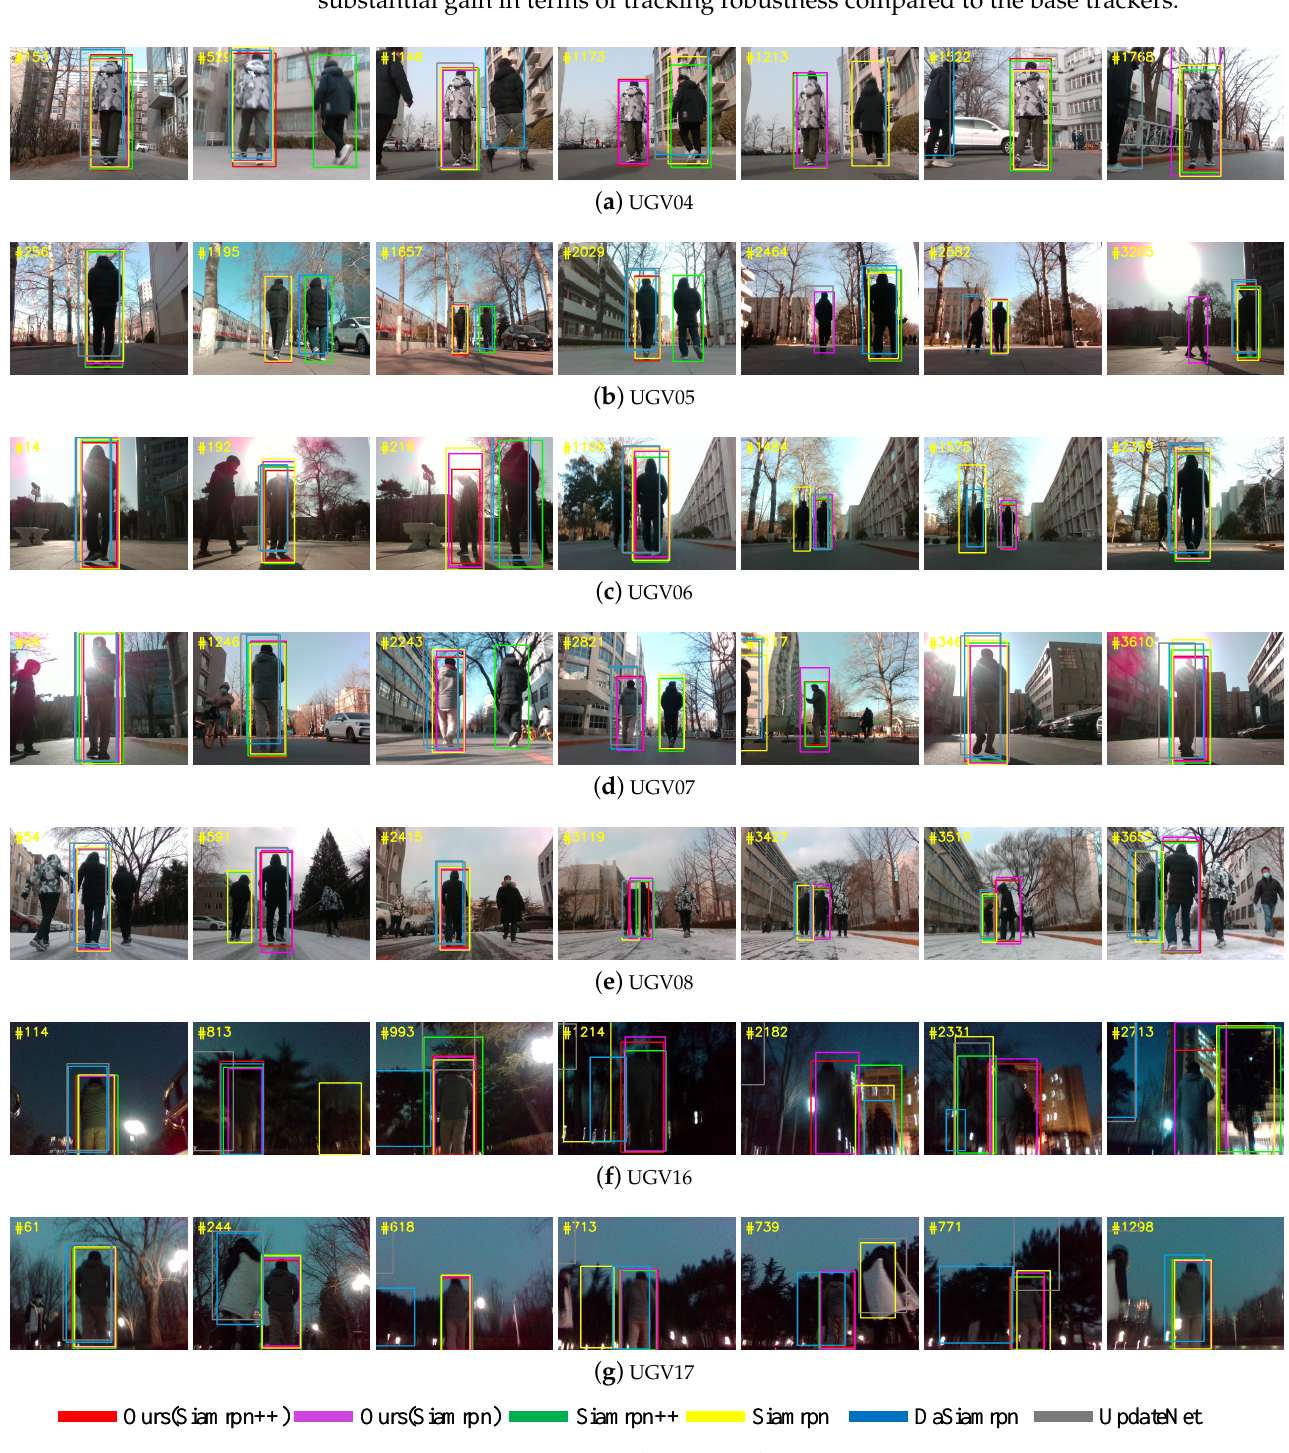
Figure 8. Qualitative